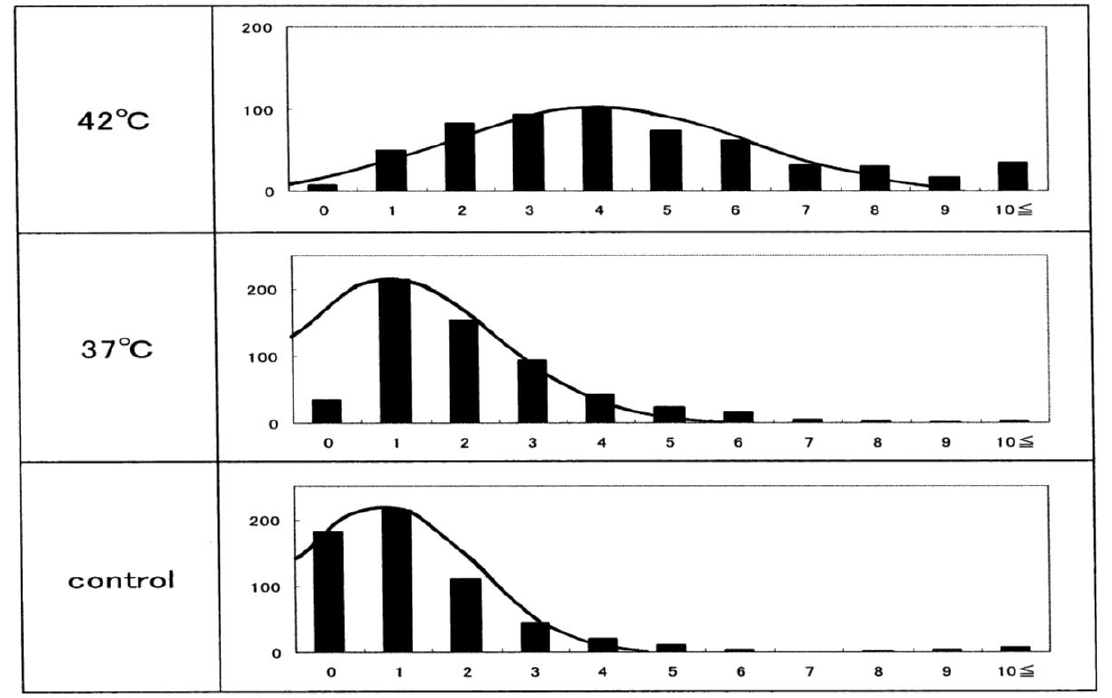
Figure 5. Histograms obtained from the arithmetic summation of all histograms shown in Figure 4, redrawn from Sugawara et al. [14]. The solid lines show the computed curve obtained by the least-squares method using a Gaussian curve. The resulting Gaussian constants are summarized in the